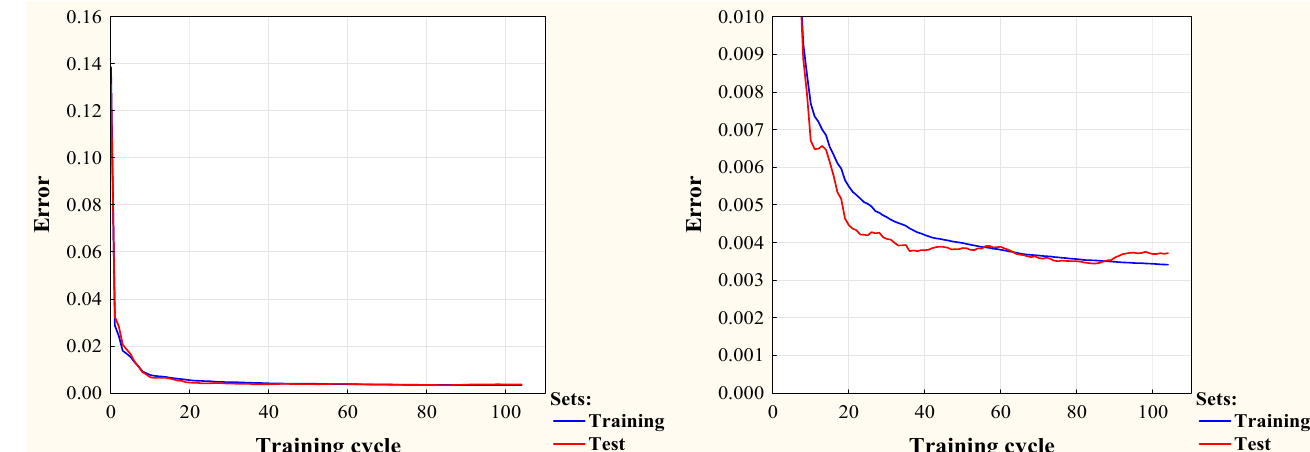
Figure 4. Learning plot of the MLP 22-10-3 artificial neural network.